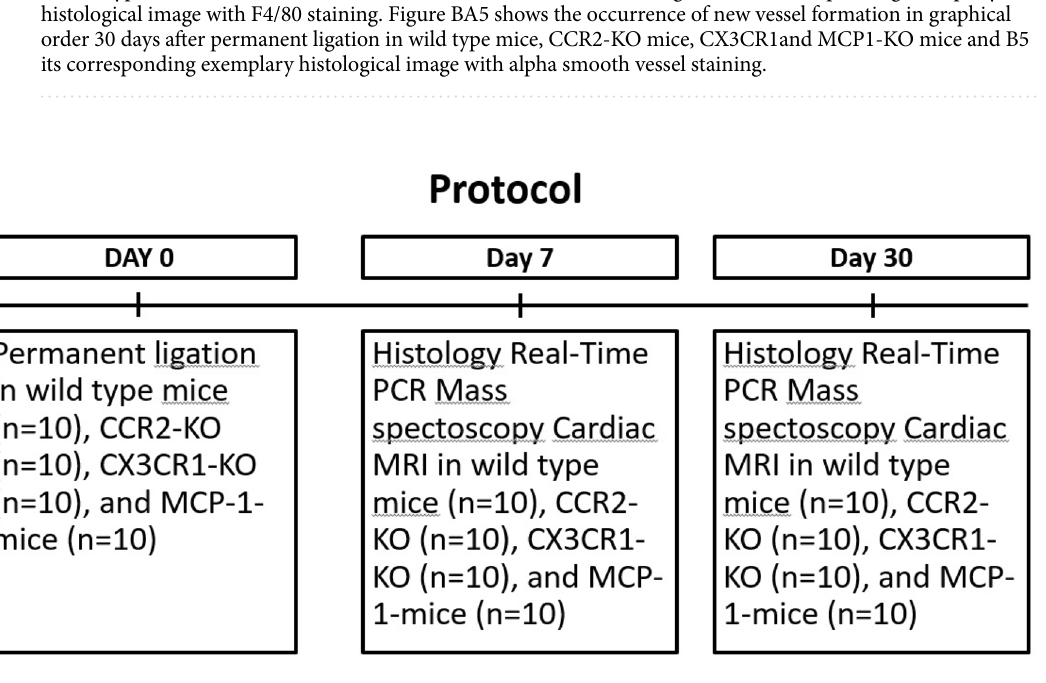
Figure 5. Cardiac remodeling in a histological follow-up regarding the scar-components elastin, collagen, monocyte-occurrence and blood supply. Figure AA1 shows the Graph of elastin occurrence 7 days after permanent ligation in wild type mice, CCR2-KO mice, CX3CR1and MCP1-KO mice. Figure A1 exhibits its corresponding exemplary histological image with Elastica-van Giesson-staining. Figure AA2 represents the graph of collagen deposit 7 days after permanent ligation in wild type mice, CCR2-KO mice, CX3CR1 and MCP1-KO mice and figure A2 represents the corresponding exemplary histological image with Picrosirius red staining. Figure AA3 indicates the graph of scar formation 7 days after permanent ligation in wild type mice, CCR2-KO mice, CX3CR1 and MCP1-KO mice and figure A3 exhibits the corresponding exemplary histological image with the aid of Masson’s Trichrome staining. Figure AA4 exhibits inflammation in graphic formation 7 days after permanent ligation in wild type mice, CCR2-KO mice, CX3CR1 and MCP1-KO mice and figure A4 its corresponding exemplary histological image with F4/80 staining. Figure AA5 shows the occurrence of new vessel formation in graphical order 7 days after permanent ligation in wild type mice, CCR2-KO mice, CX3CR1 and MCP1-KO mice and A5 its corresponding exemplary histological image with alpha smooth vessel staining. Figure BA1 points out the Graph of elastin occurrence 30 days after permanent ligation in wild type mice, CCR2-KO mice, CX3CR1 and MCP1-KO mice. Figure B1 exhibits its corresponding exemplary histological image with the aid of Elastica-van-Giesson staining. Figure BA2 represents the graph of collagen deposit 30 days after permanent ligation in wild type mice, CCR2-KO mice, CX3CR1 and MCP1-KO mice and figure B2 represents the corresponding exemplary histological image with Picrosirius red staining. Figure BA3 indicates the graph of scar formation 30 days after permanent ligation in wild type mice, CCR2-KO mice, CX3CR1and MCP1-KO mice and figure B3 exhibits the corresponding exemplary histological image with the aid of Masson’s Trichrome staining. Figure BA4 exhibits inflammation in graphic formation 30 days after permanent ligation in wild type mice, CCR2-KO mice, CX3CR1and MCP1-KO mice and figure B4 its corresponding exemplary histological image with F4/80 staining. Figure BA5 shows the occurrence of new vessel formation in graphical order 30 days after permanent ligation in wild type mice, CCR2-KO mice, CX3CR1and MCP1-KO mice and B5 its corresponding exemplary histological image with alpha smooth vessel staining.